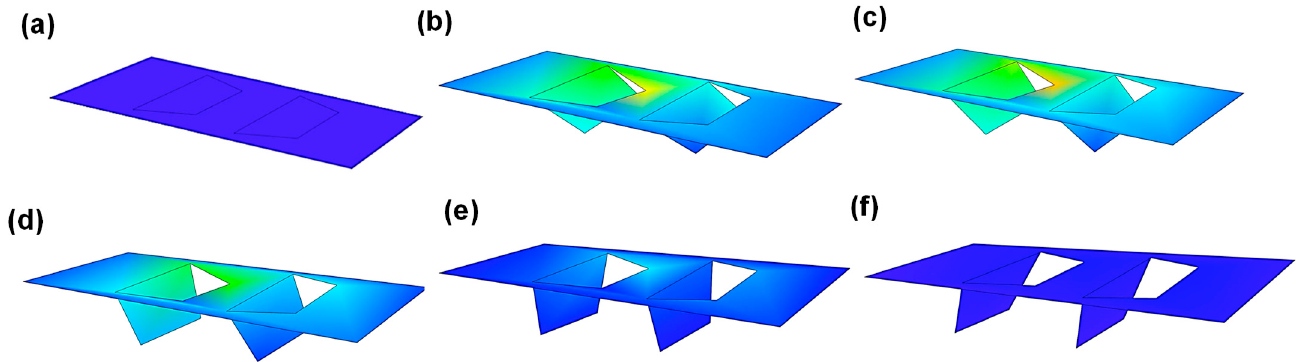
Figure 7. Strain visualization of the movement of triangular prism mechanism. ( a – f ) show changes in strain level versus time.